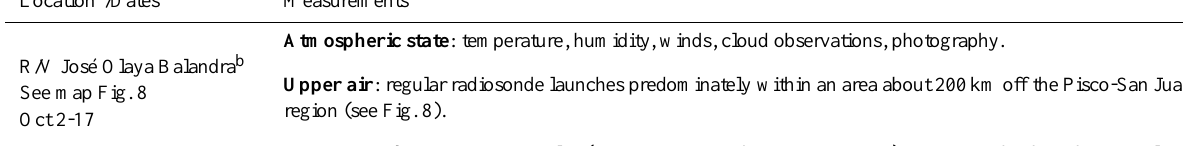
Table 4. Details of the R/V Jos´e Olaya Balandra measurements in VOCALS-REx. Location a /Dates